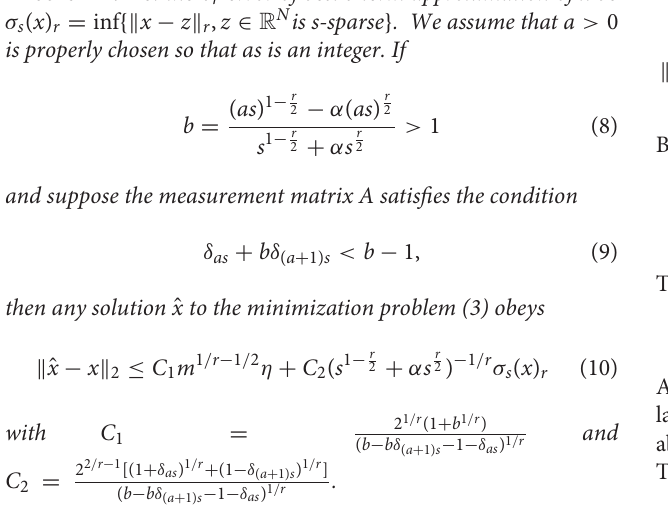
FIGURE 1 | The contour plots for weighted ℓ r the second row shows the cases that r